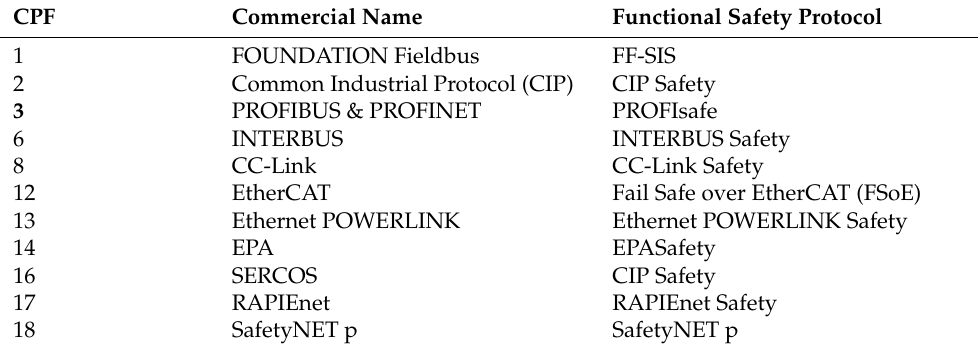
Table 1. Communication Profile Families (CPF) and Functional Safety Protocols defined by IEC 61784-3.